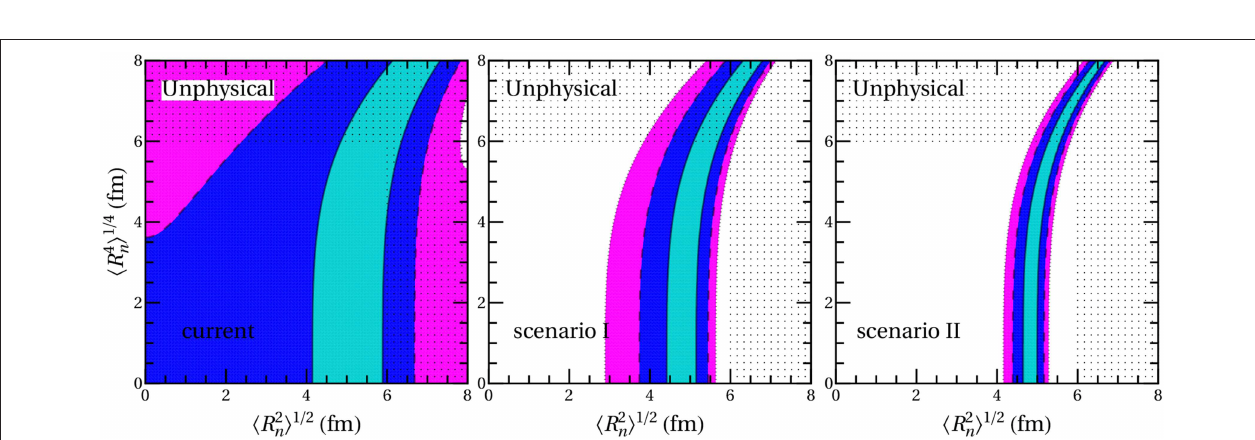
1 / 4 plane from the COHERENT data assuming the current and possible future detector specifications (see the text). 1 / 2 – R 4 n R 2 n i i h h